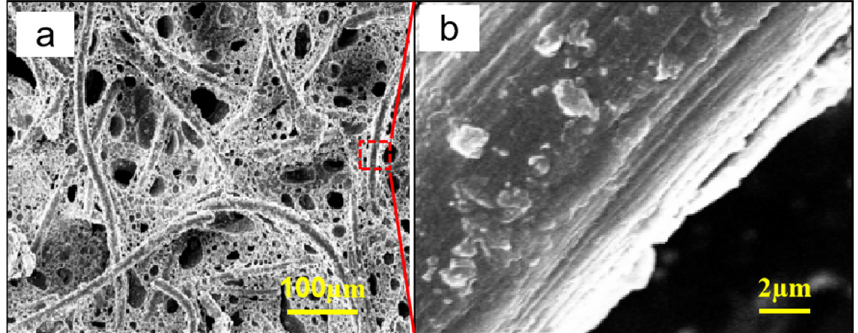
Figure 5. Morphology of the A-CF/EP/FEP composite with 50%